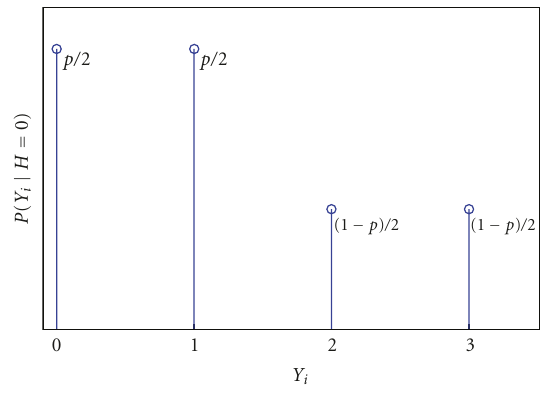
Figure 4: Probability mass function P ( Y i | H = 0) of 2-bit observation Y i made by sensor node S i . Here p is the precision of sensor and in general p > 0 . 5. For the above plot, an example value of precision p = 0 . 7 has been